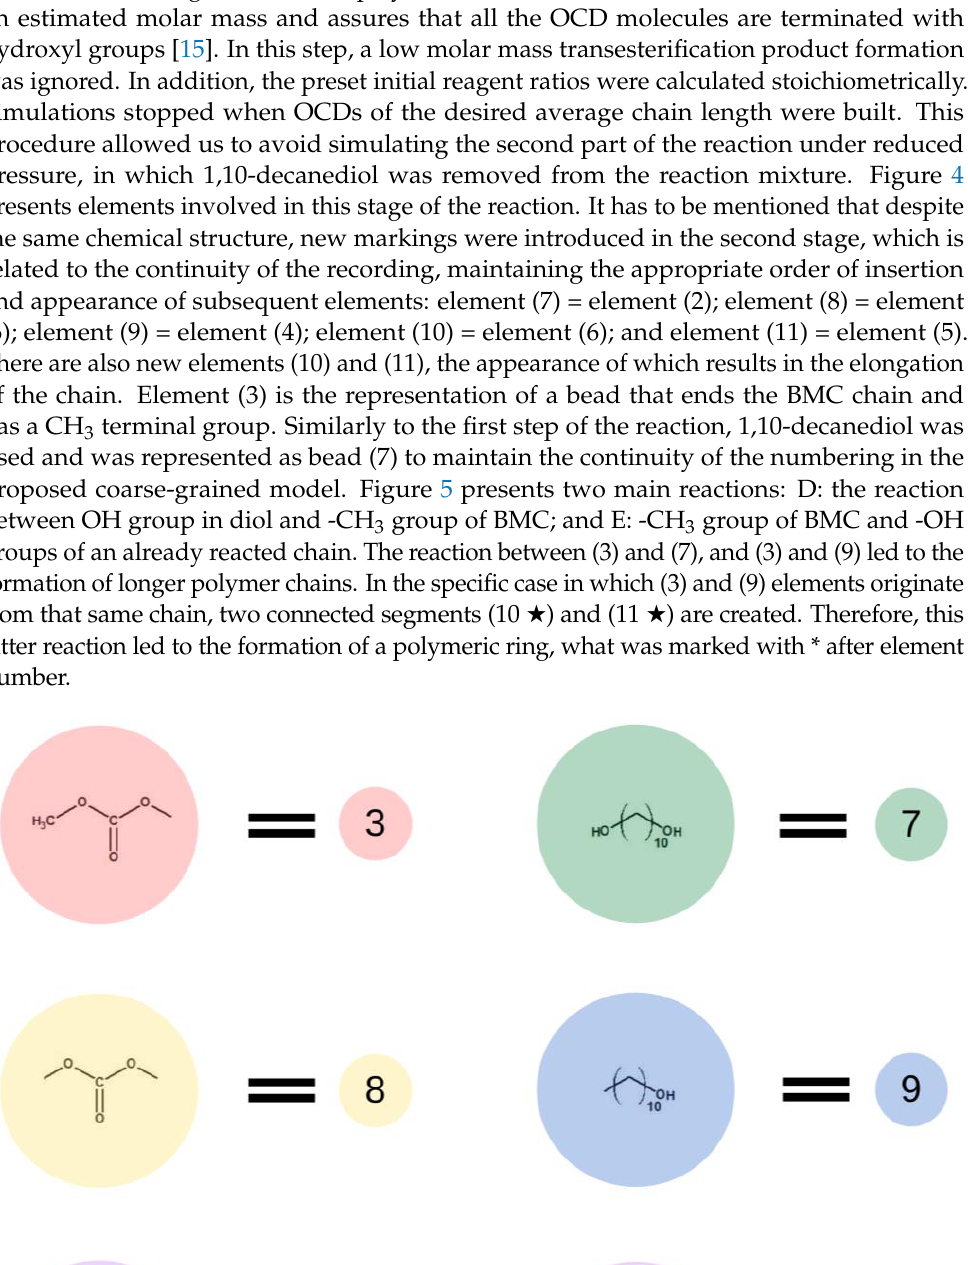
Figure 5. An illustration of the process of oligo(decamethylene carbonate) synthesis. In the case of elements (10) and (11) originated from that same polymeric chain the polymeric ring is formed, which was illustrated with * after elements numbers.